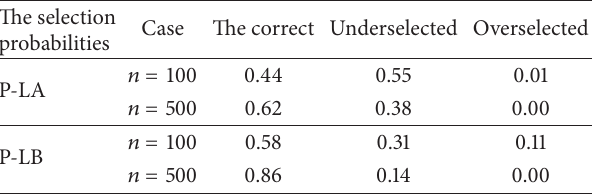
Table 2: The selection probabilities of adaptive GMM shrinkage